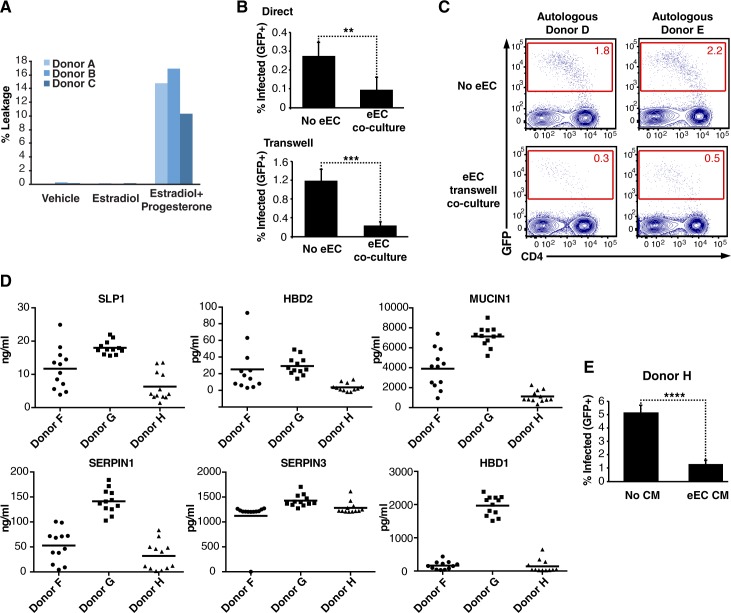
eEC inhibit HIV infection of CD4+ T cells and secrete antivirals.(A) eEC from 3 donors were co-cultured in a transwell with autologous eSF in the basolateral chamber for 6–7 days without hormones (vehicle), with estradiol only (mimicking the follicular phase), or with both estradiol and progesterone (mimicking the luteal phase). Epithelial permeability was monitored by quantitating leakage of phenol red from the apical to the basolateral chamber. (B) PHA/IL2-activated PBMCs were infected with NLENG1I with or without eEC co-culture, and monitored 3 d later for levels of productive infection. PBMCs were either in direct contact with eEC, or separated from them through use of a transwell. Results are gated on live, singlet CD3+CD8- cells, and are representative of data from three donors. **p<0.01, ***p<0.001 (by 2-tailed t test). (C) PHA/IL2-activated PBMCs cultured with or without autologous eEC were infected with NLENG1I and monitored for infection levels 3 d later. Results are gated on live, singlet CD3+ cells. (D) Secreted levels of the top six anti-HIV factors overexpressed in eEC relative to eSF. The levels of SLPI, HBD2, SERPINA3, MUC1, SERPINA1, and HBD1 were quantitated in the culture media of eEC from three donors (12 cultures per donor) after 48 h. (E) Activated PBMCs were infected with NLENG1I with or without eEC-conditioned media and harvested 3 d later to monitor levels of productive infection. Data are representative of three independent experiments with CM from three different eEC donors. Results are gated on live, singlet CD3+CD8- cells. ****p<0.0001 (by 2-tailed t test).